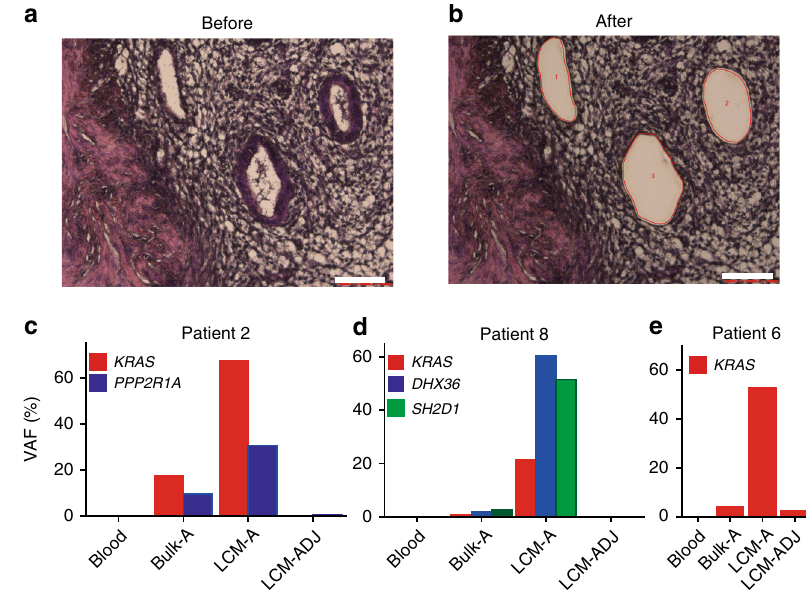
Fig. 2 Somatic mutations in the epithelial component of adenomyosis lesions. a , b HE staining of epithelial cells from adenomyosis Patient #6 ( a ) before and ( b ) after isolation by laser capture microdissection (LCM). Scale bars, 100 μ m. c – e Quanti fi cation of VAF as determined by TDS of the indicated genes in peripheral blood (Blood), frozen adenomyosis lesions (Bulk-A), LCM-acquired epithelial component of adenomyosis (LCM-A), or LCM-acquired adjacent muscle cells (LCM-ADJ) from the indicated